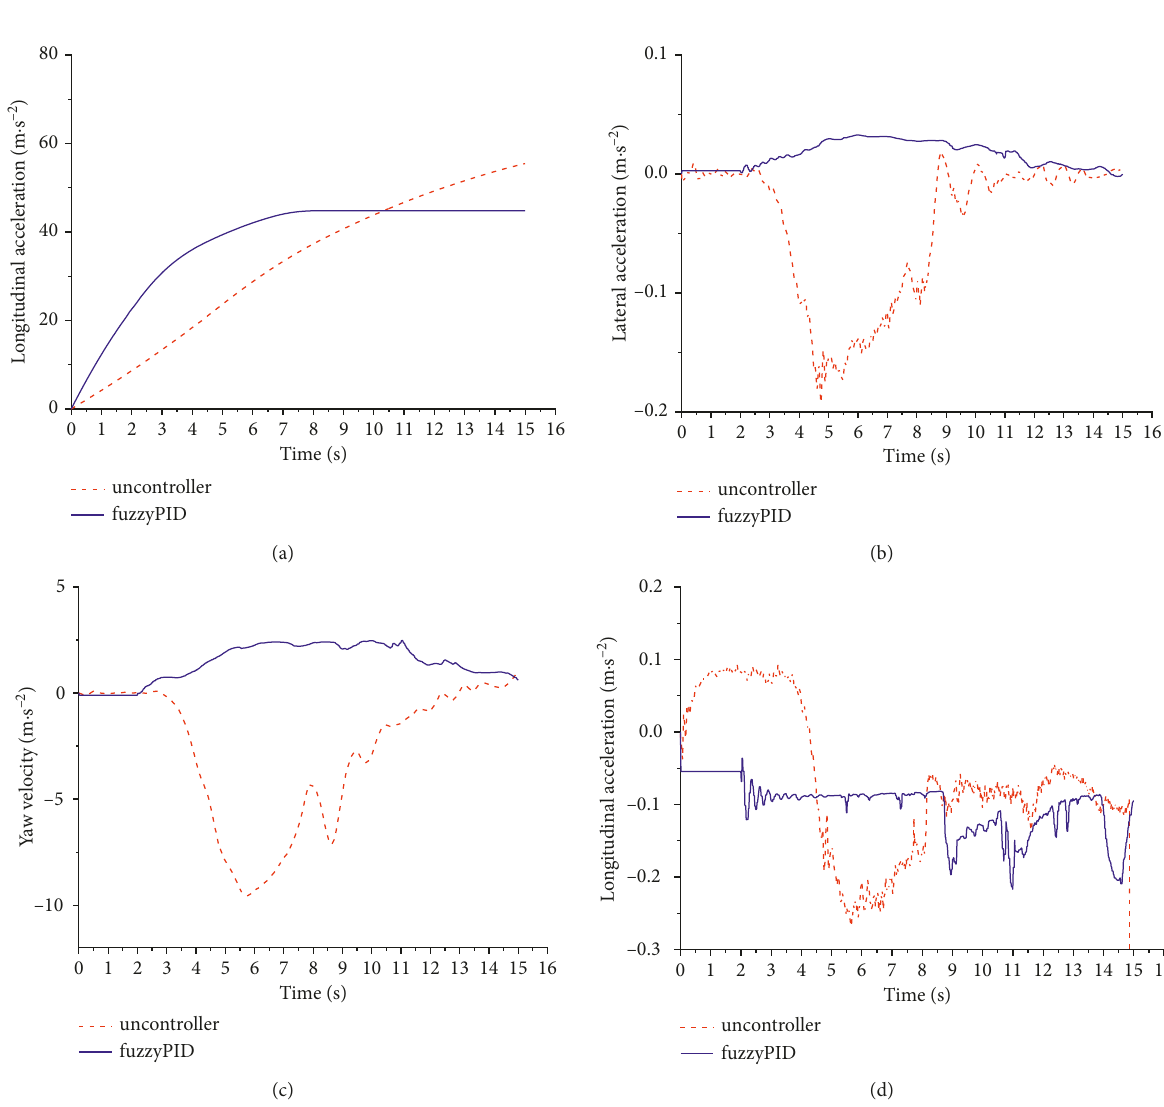
Figure 31: HIL test diagram under curve operating conditions when u � 0.4. (a) Braking distance. (b) Lateral acceleration. (c) Yaw velocity. (d) Longitudinal acceleration.